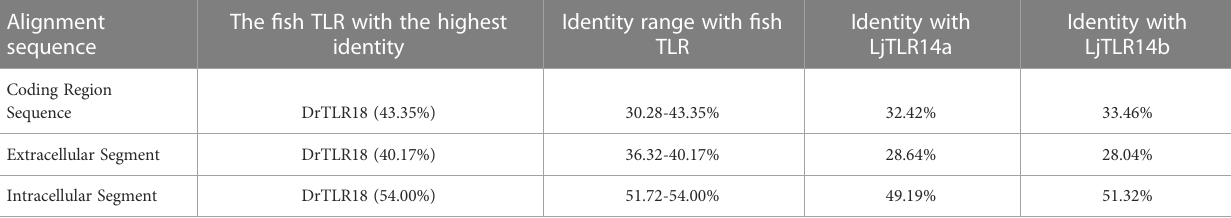
TABLE 1 Brief analysis of LmTLR14d